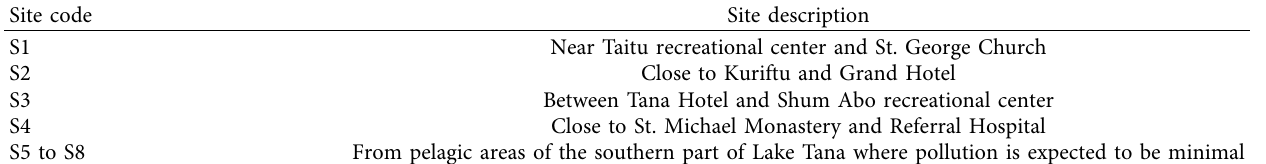
Table 1: Sampling sites and description at the Southern Gulf of Lake Tana, 2021.